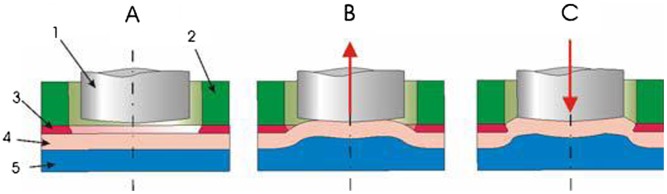
Operational sequence of the hydro-clinching [224].